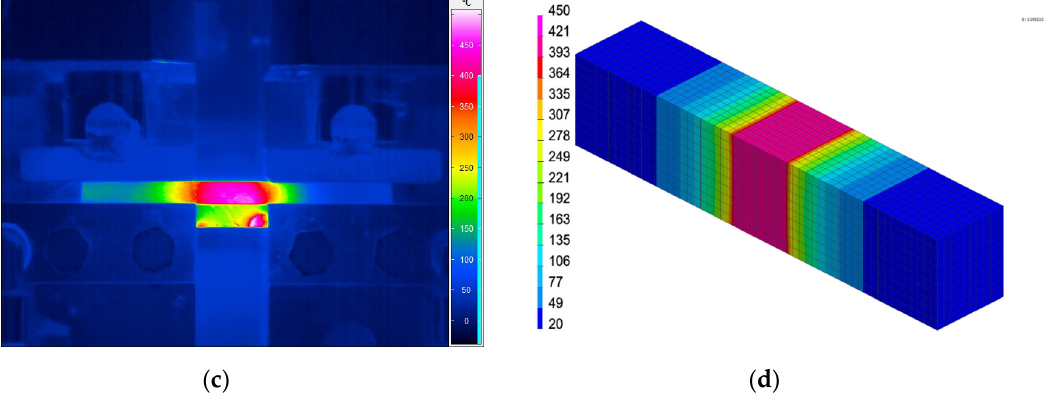
Figure 6. Comparison of ( a ) the registered and ( b ) the calculated thermal cycle as well as ( c ) the thermographic image and ( d ) the result of the numerical analysis in the form of temperature distribution for the thermal cycle with T max = 400 °C.